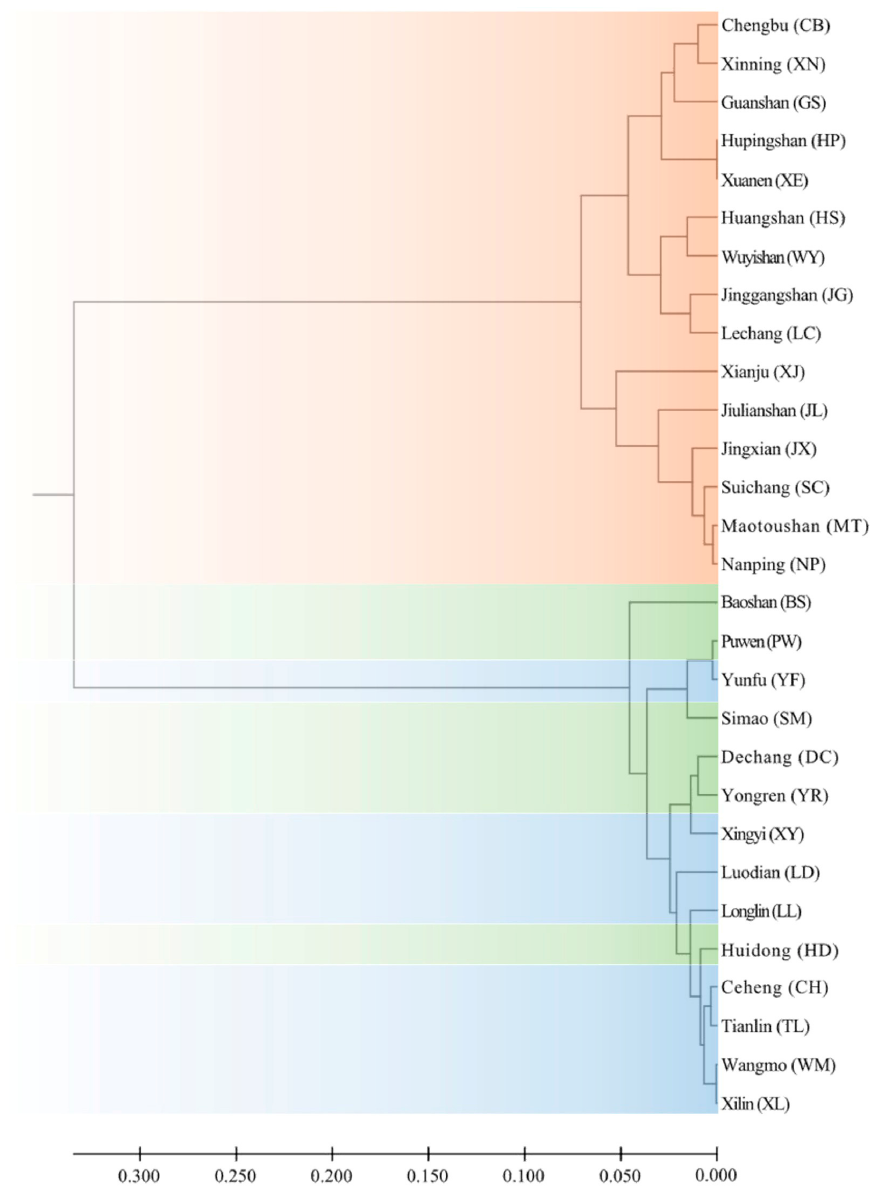
Figure 5. Phylogenetic relationships among 29 populations derived from nrDNA ITS sequences in T. ciliata complex. UPGMA (unweighted pair-group method using arithmetic average) was used to draw clusters. The populations in three colors correspond to the three clusters derived from the mtDNA marker in Figure 4.